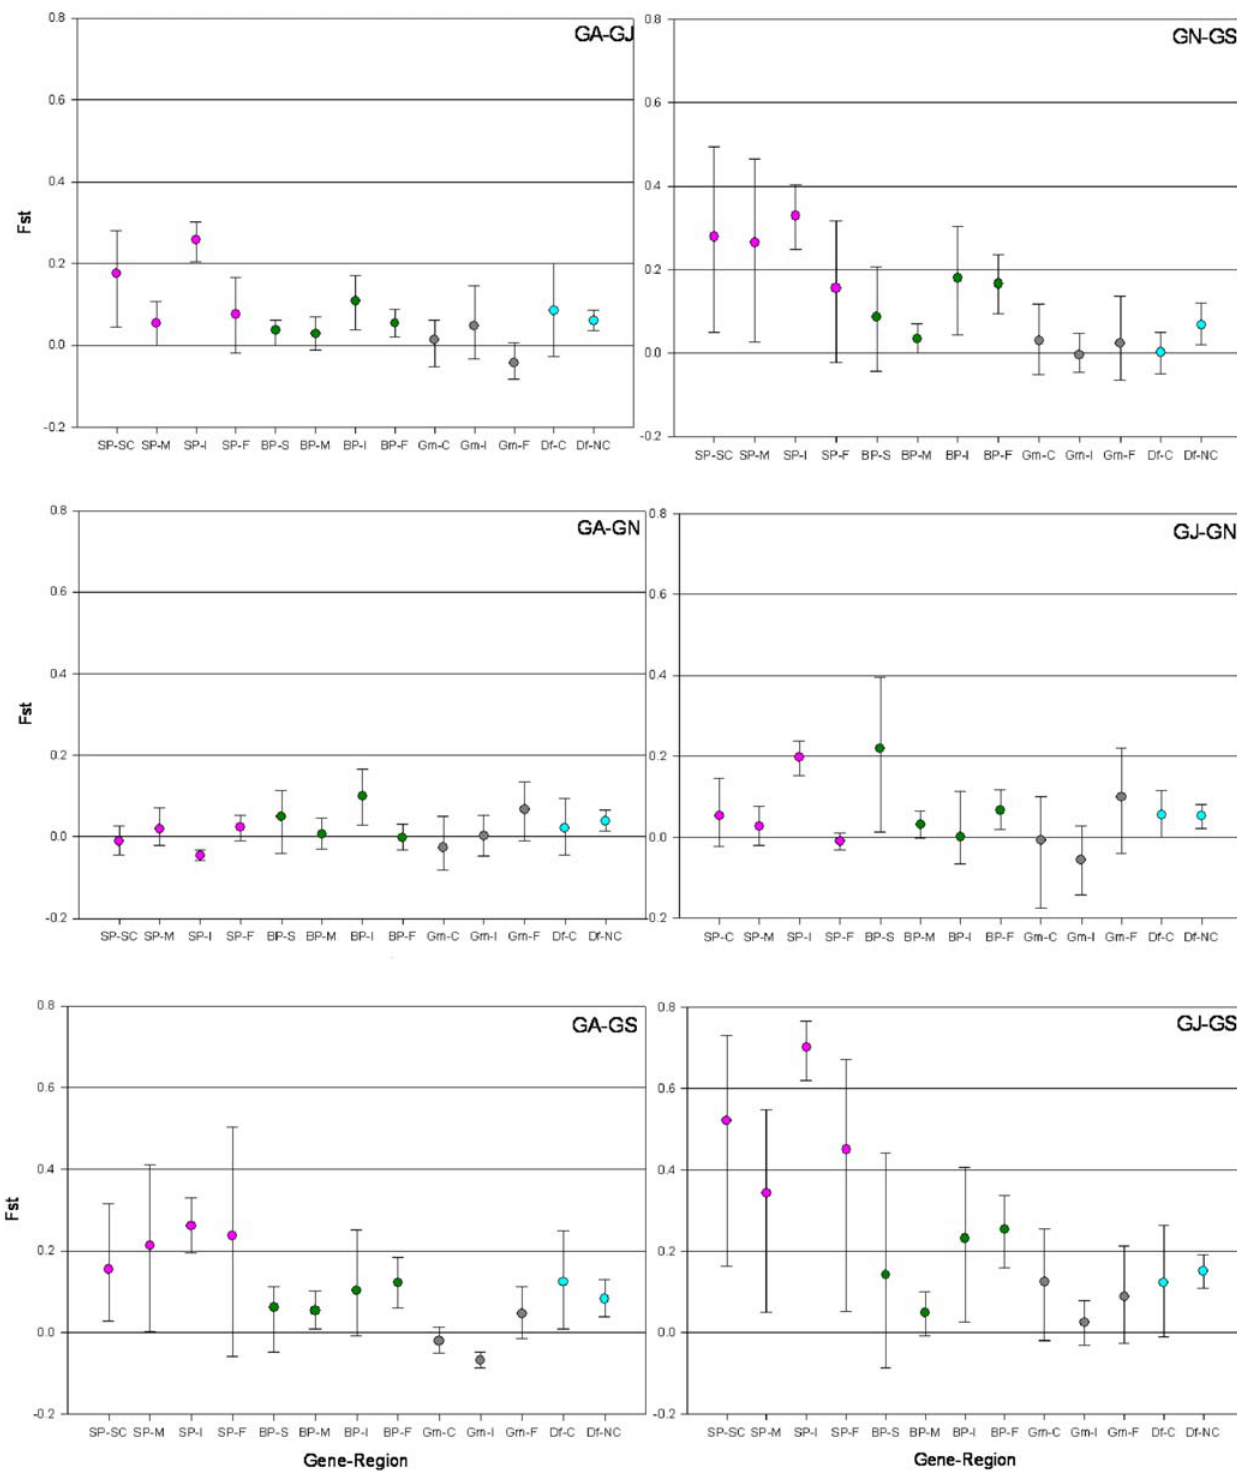
Figure 5. Differentiation between An. gambiae populations measured by F ST in different functional regions of each gene. The 95% CI of each value were estimated by bootstrapping over positions (1000 bootstrap replications) provided that there were five or more variable positions in that gene segment across the pair of populations compared. The number of variable positions is shown if it is below 10. Horizontal axis legend is the same as in Figure 4.